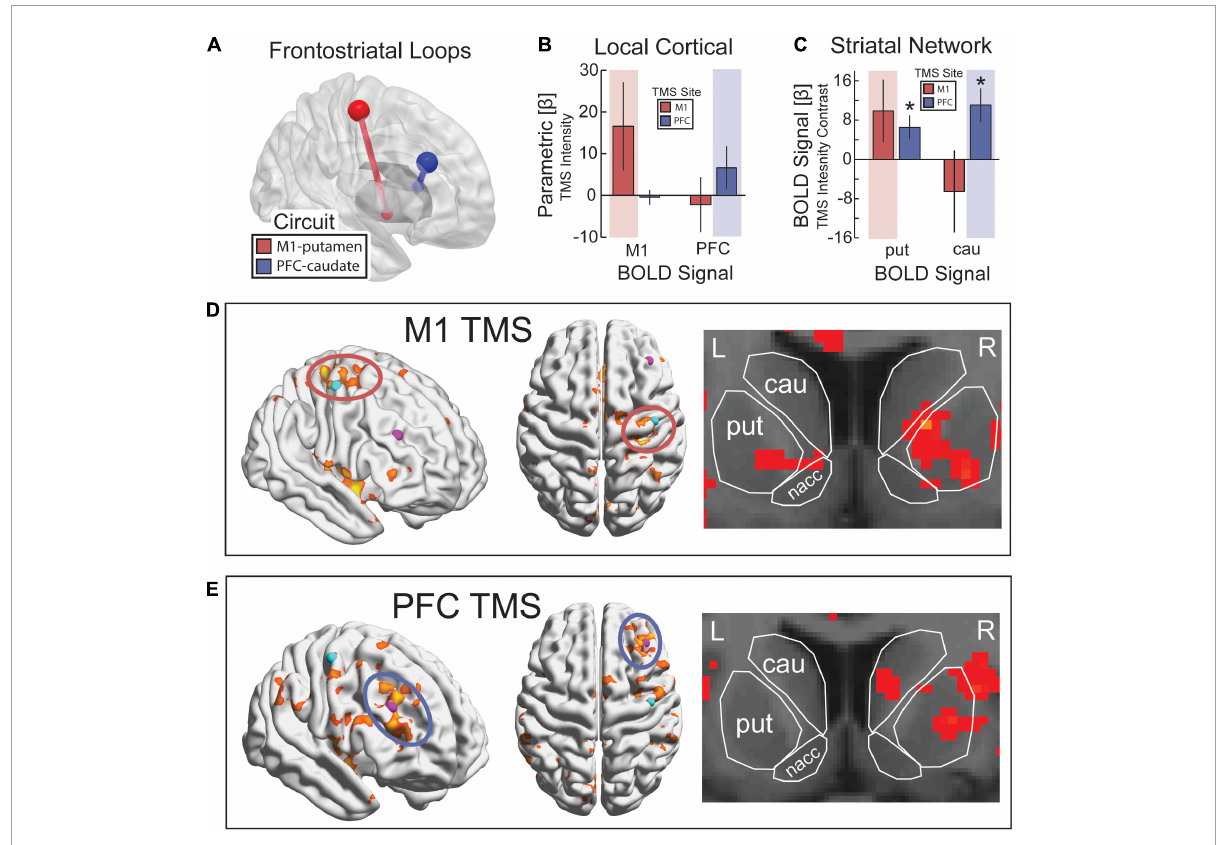
FIGURE4 Targeting frontostriatal loops with continuous TMS-fMRI. (A) TMS to M1 (red) and PFC (blue) with anatomical projections to posterior putamen and dorsal caudate, respectively. (B) As TMS intensity was increased, we expected a parametric increase in evoked BOLD activity from TMS in the region of the cerebral cortex targeted by TMS (red background for M1 and blue background for PFC). (C) Parametric contrast of TMS intensity on evoked activity in putamen and caudate. Highlighted regions reflect the predicted increase in activity based on anatomical projections. Error bars are SEM. * p < 0.05. Statistical map for the parametric contrast of TMS intensity with TMS to M1 (D) and PFC (E) . p < 0.05, k > 500. (D) k > 500, (E) k >